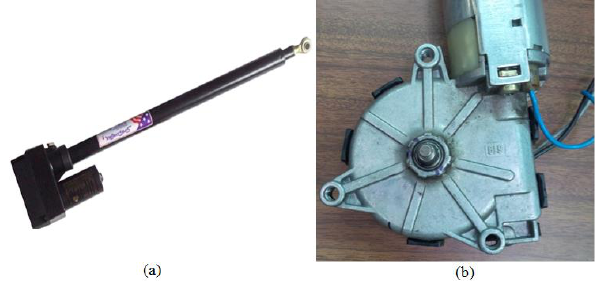
Figure 15. Tracker motors: (a) linear actuator, (b) electric